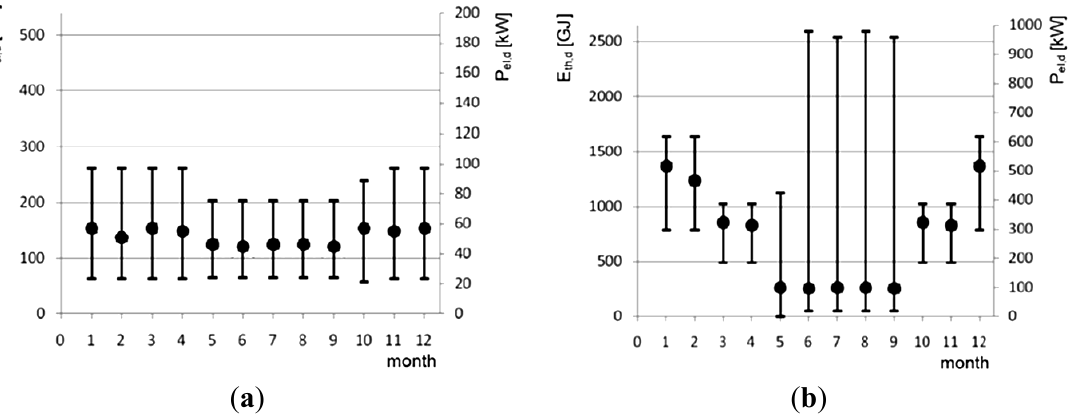
Figure 7. Hotel monthly ( a ) electric and ( b ) thermal load yearly behaviour. Left axis: monthly energy demand ( ● ). Right axis: Variation of daily power request on monthly basis